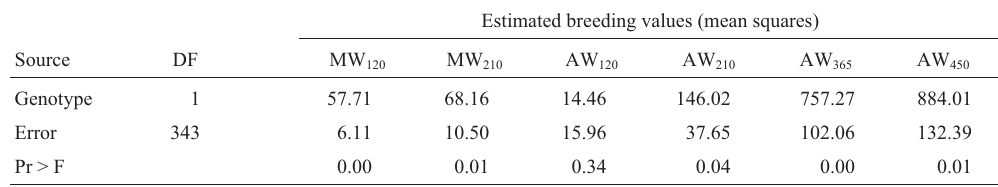
Table 2 - Analysis of variance between weight estimated breeding values (EBV) for the G5501 → T (G, n = 247; T, n = 71) mitochondrial tRNA asn gene single nucleotide polymorphism (SNP). The table shows degrees of freedom (DF) and the mean square values for maternal EBV for weight (MW) at 120 and 210 days and animal EBV for weight (AW) at 120, 210, 365 and 450 days.